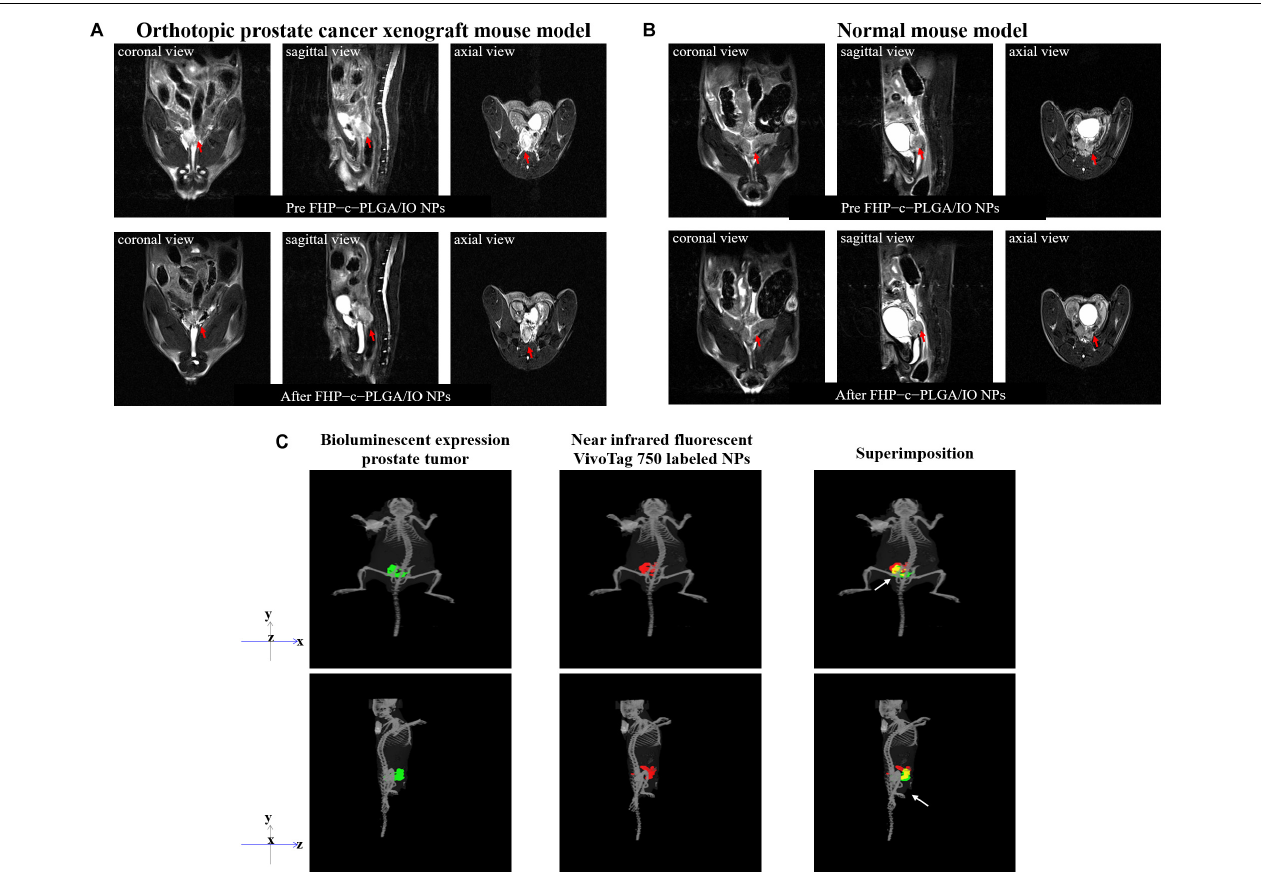
FIGURE 6 | In vivo T2-weighted axial MR images were acquired before and after injection of FHP–c–PLGA/IO NPs from untreated and xenografted mice. A decrease in signal intensity caused by FHP–c–PLGA/IO NPs was observed in prostate tumor tissue (red arrows) but not in normal prostate tissue. (A) Orthotopic prostate cancer xenograft mouse model. (B) Normal mouse model. (C) Three-dimensional bioluminescence or fluorescence optical tomography using in vivo imaging system (IVIS) Spectrum CT. The co-localization (yellow) of bio-luminescent prostate tumors (green) with VivoTag 750-labeled NPs (red) in the prostate tissue (white